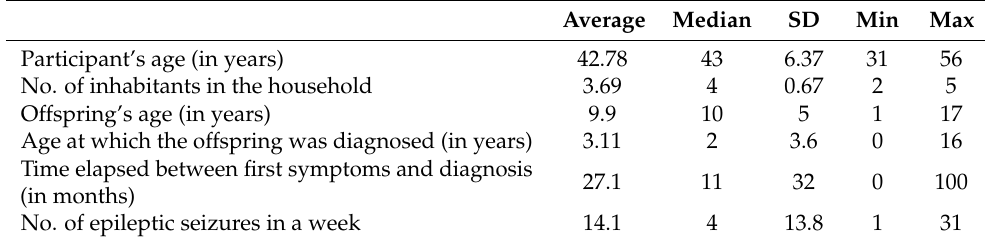
Table 1. Socio-demographic